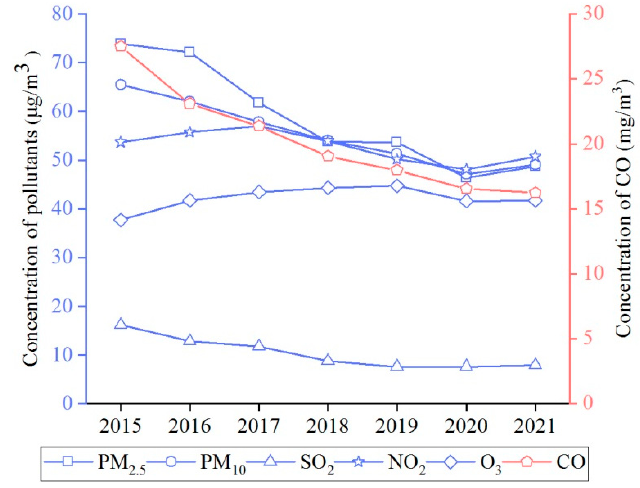
Figure 9. Temporal trend of pollutants including PM 2.5 , PM 10 , O 3 , SO 2 , NO 2 (blue), and CO (red) from 2015 to 2021.